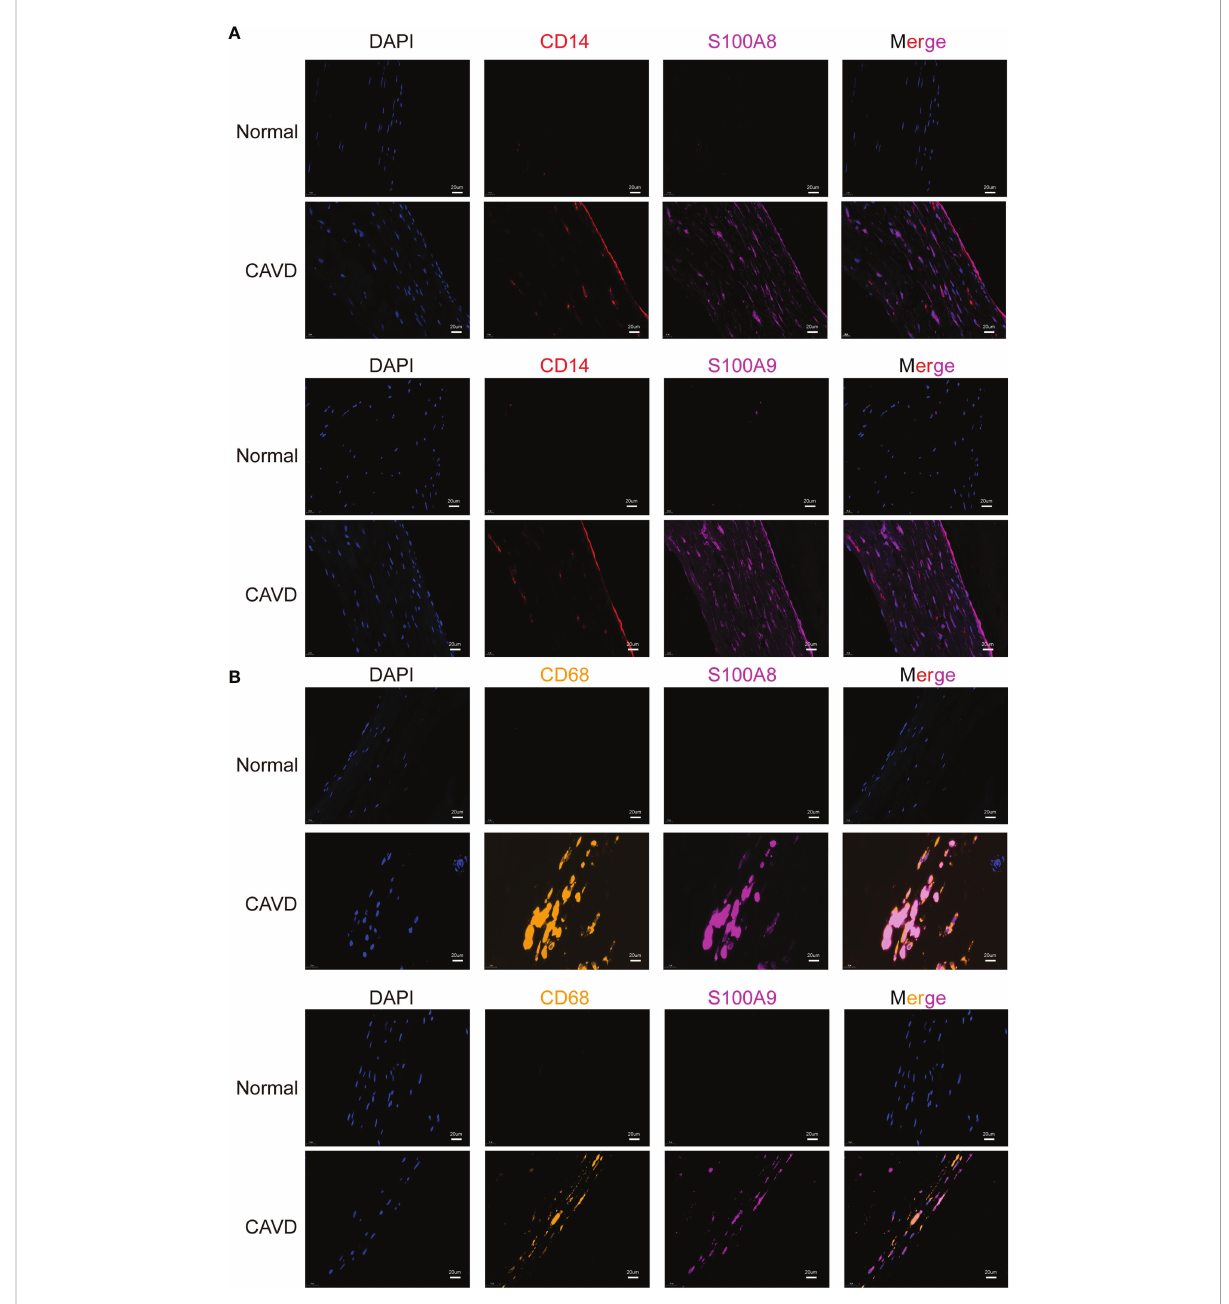
FIGURE 13 Colocalization of hub genes ( S100A8 and S100A9 ) and CD14 and CD68 staining. Immuno fl uorescence analysis of CD14/S100A8 and S100A9 (A) . The human aortic valve was stained with anti-CD14 (red) and anti-S100A8/S100A9 (purple) antibodies. S100A8 and S100A9 partly co- localized with monocytes. Immuno fl uorescence analysis showed CD68/S100A8 and S100A9 expression (B) . The human aortic valve was stained with anti-CD68 (yellow) and anti-S100A8/S100A9 (purple) antibodies. The scale bar represents 20 m